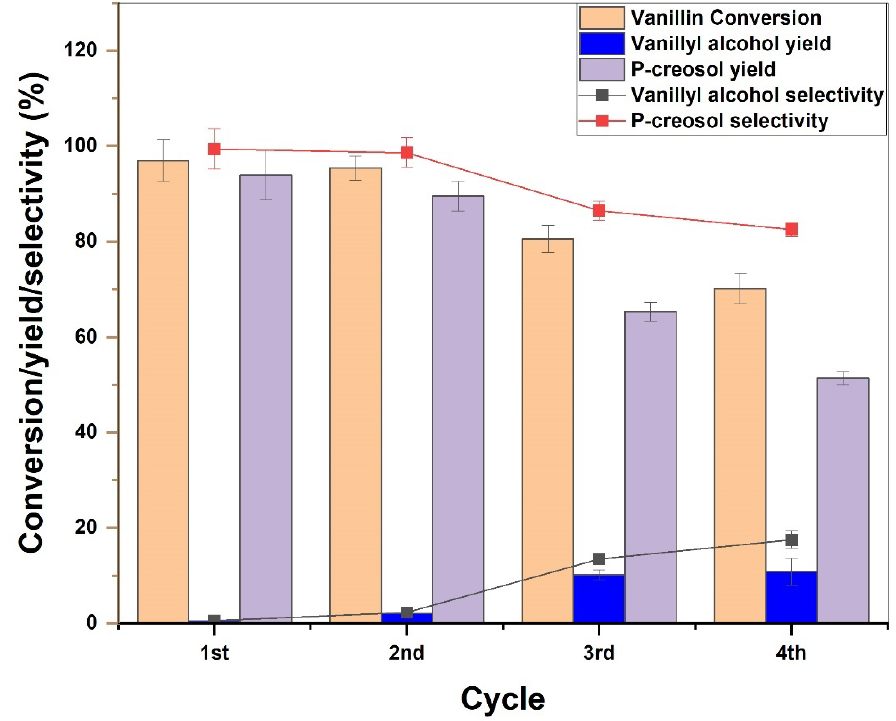
Figure 12. Catalyst stability study, showing product yield and selectivity over 4 cycles of reuse (reaction conditions: initial substrate concentration 0.33 M, temperature 150 °C, H 2 pressure 50 bar, catalyst 0.8 g, reaction time 9.5 h).